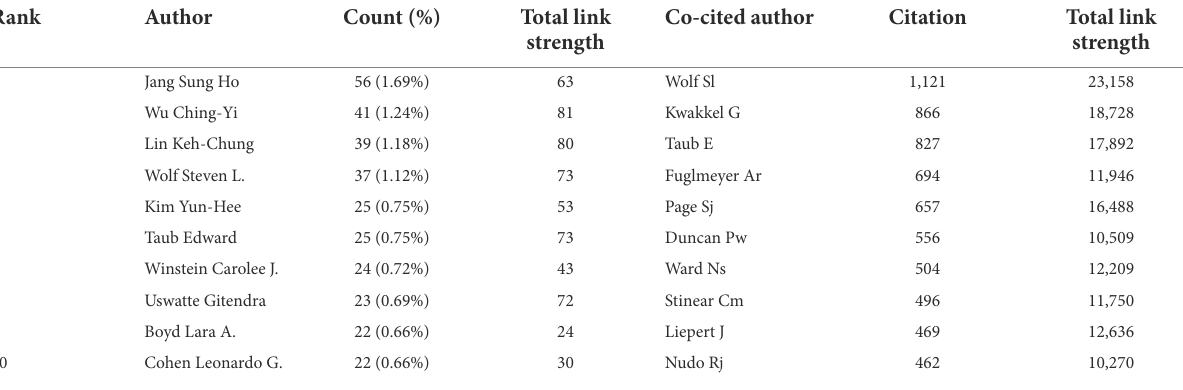
TABLE 2 Top 10 authors and co-cited authors related to stroke motor function